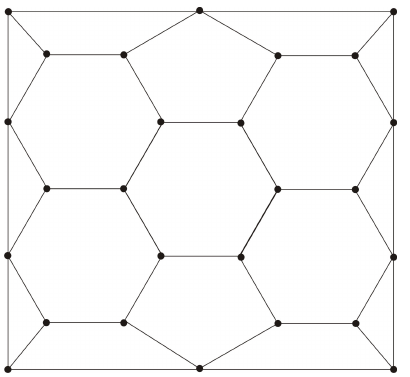
Figure 2. Example of connected planar graph.